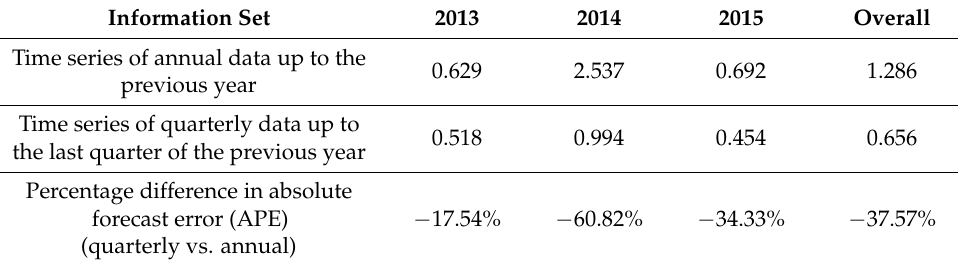
Table 3. Comparing forecast performance: Absolute percentage error